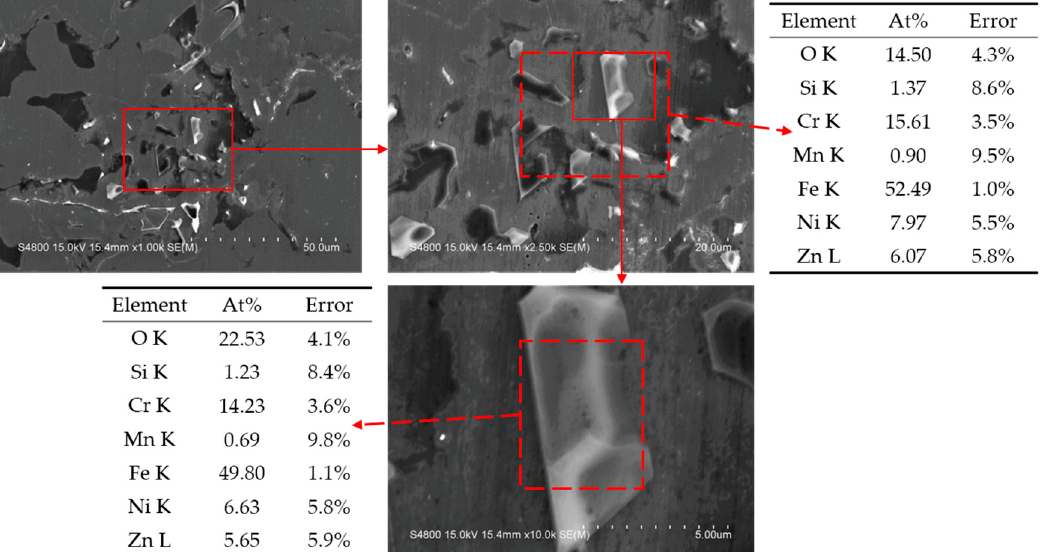
Figure 10. SEM images and the corresponding composition analysis of the passive film formed on 304L with the zinc–aluminum treatment.